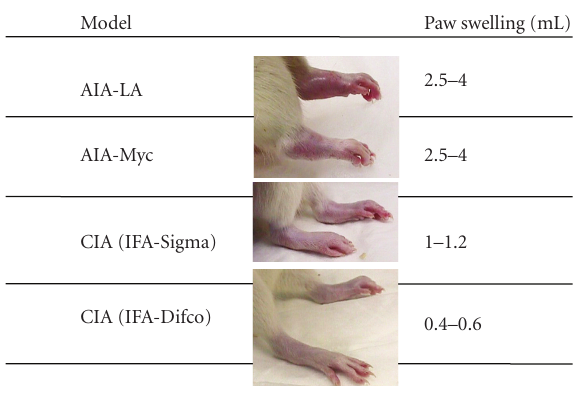
Figure 3: The severity of immune-mediated joint disease in rats varies with the model and the choice of reagents. Adjuvant-induced arthritis induced in young adult, male Lewis rats using either lipodal amine (AIA-LA) or Mycobacterium tuberculosis (AIA-Myc) produces extreme swelling and reddening of the tibiotarsal region (hock (or “ankle”)) (upper image) relative to the changes that develop in young adult, female Lewis rats with collagen-induced arthritis (CIA). The degree of hock expansion associated with CIA induction using incomplete Freund’s adjuvant (IFA) from Sigma Chemical Co. (St. Louis, MO) (middle image) is greater than that associated with IFA provided by Difco Laboratories (Detroit, MI) (lower image). Intra-articular inoculation of streptococcal cell wall (SCW) polymers results in modest hind paw swelling (not